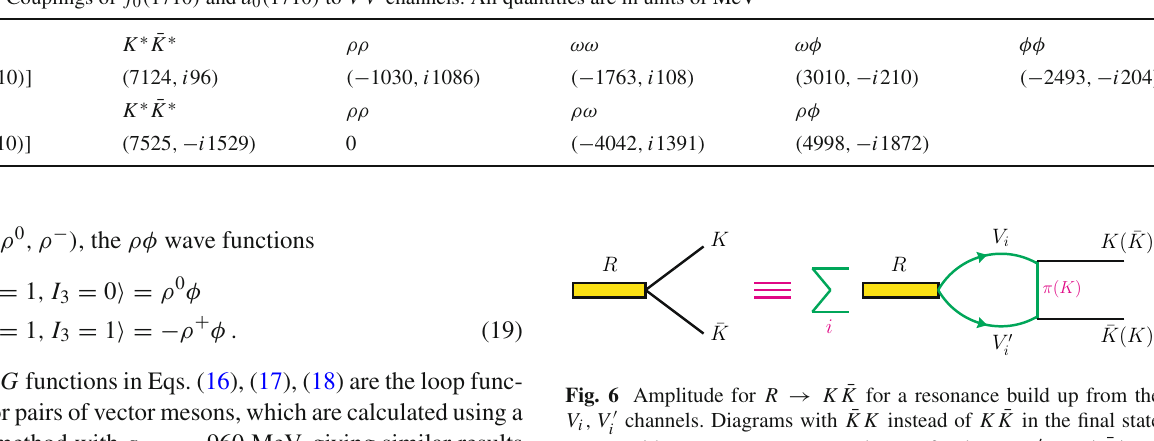
≡ K ∗ ¯ K ∗ i production corresponding S